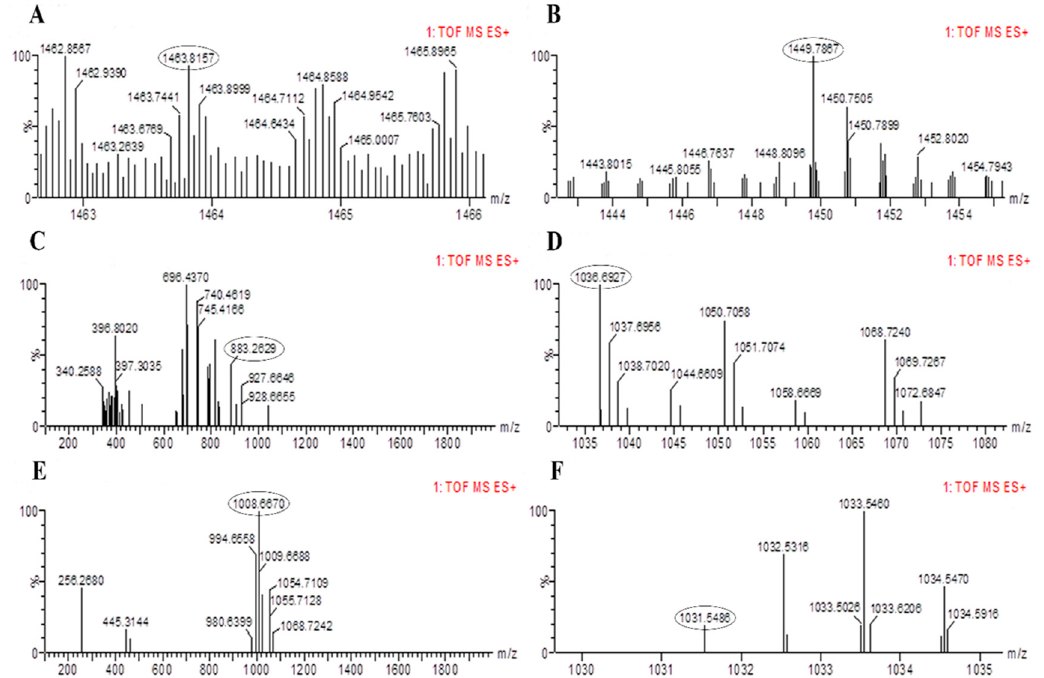
Figure 6. LC-MS chromatogram of methanolic extracts of B. amyloliquefaciens HNH9. ( A , B ) = Fengycin, ( C ) = Bacillibactin, ( D , E )= Surfactin and ( F )= Bacillomycin.